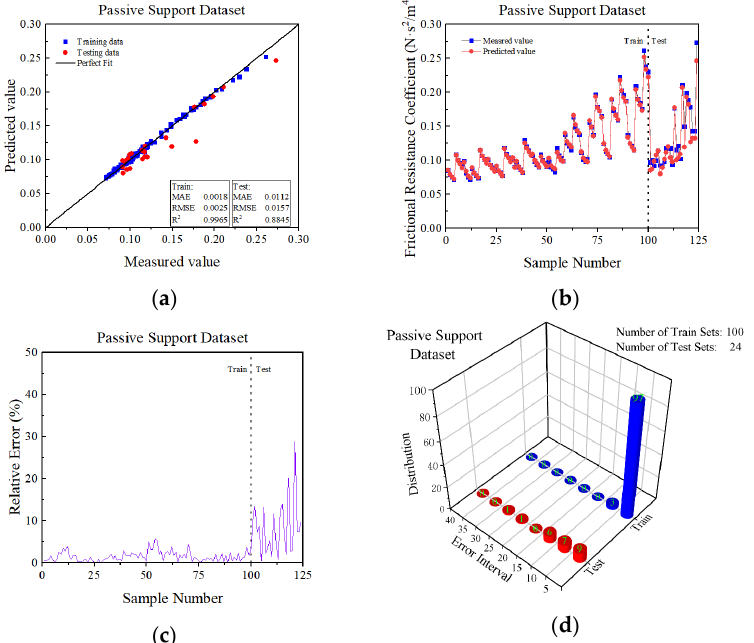
Figure 10. The passive support GSCV-RF model prediction results. ( a ) Correlation evaluation of the measured and predicted values of α; ( b ) curves of the measured and predicted values of the samples; ( c ) sample prediction error curve; ( d ) sample error frequency distribution.